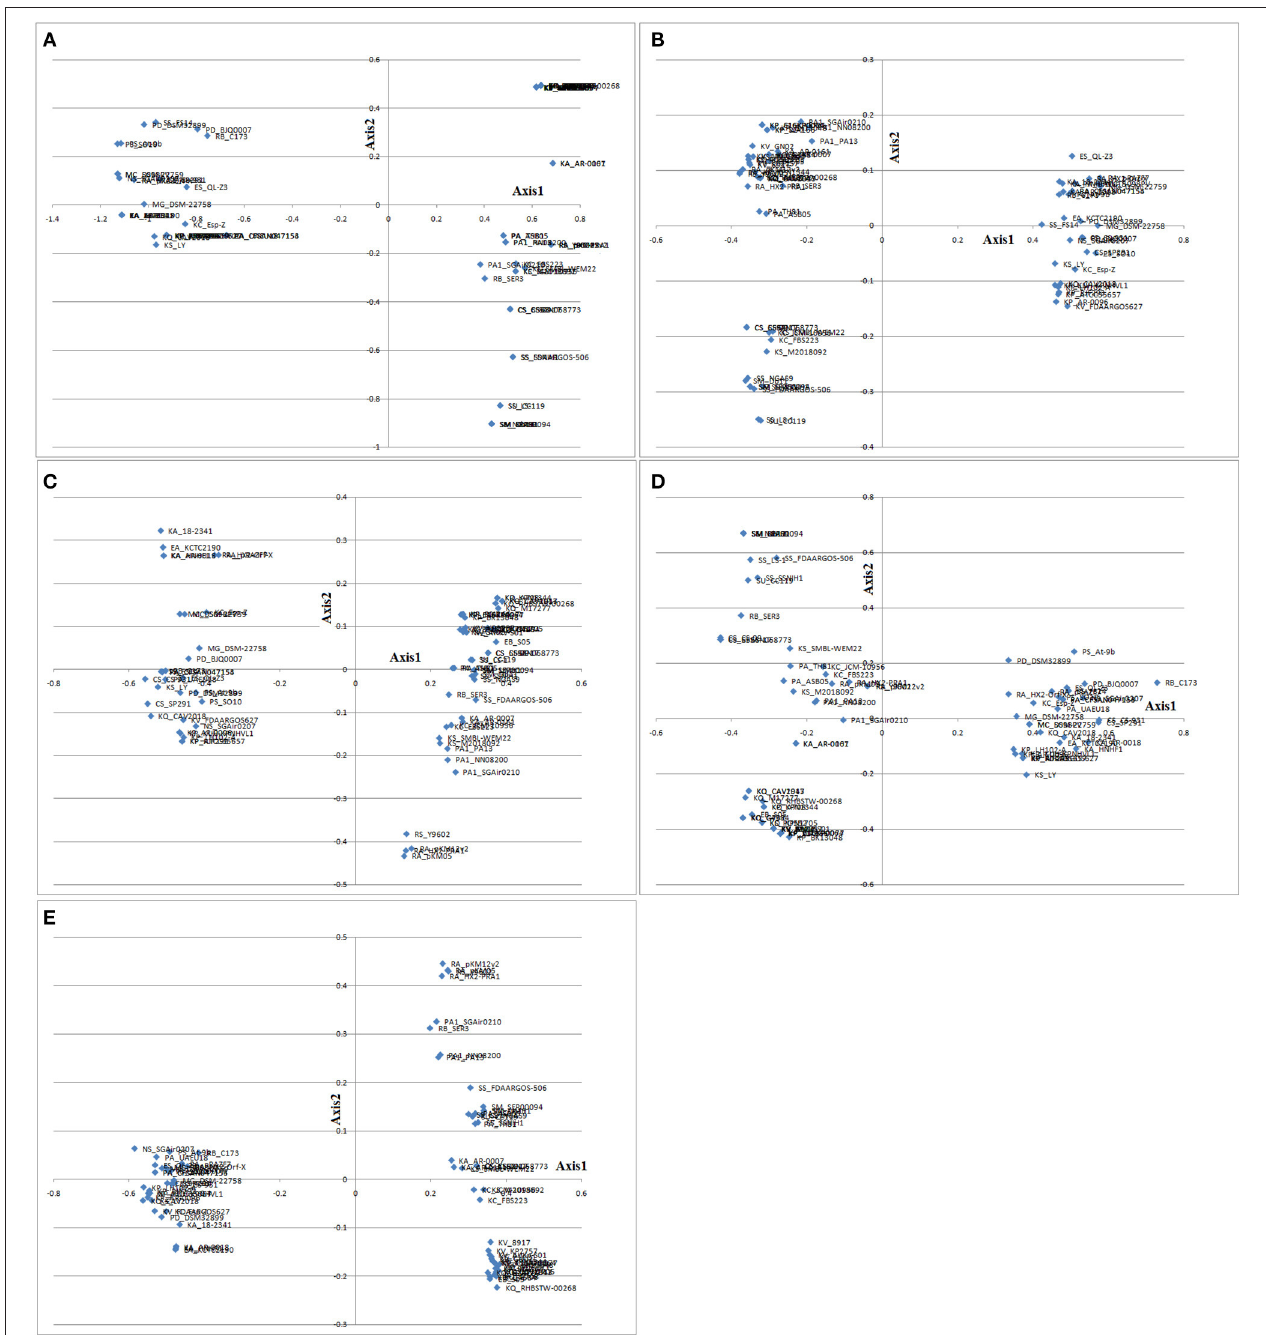
FIGURE 5 | Position of genes along the first and second axes produced by correspondence analysis based on RSCU values of the 59 synonymous codons from pqqA (A) , pqqB (B) , pqqC (C) , pqqD (D) , and pqqE (E) genes from 79 Gammaproteobacterial species. x - and y -axis correspond to Axis 1 and Axis 2.